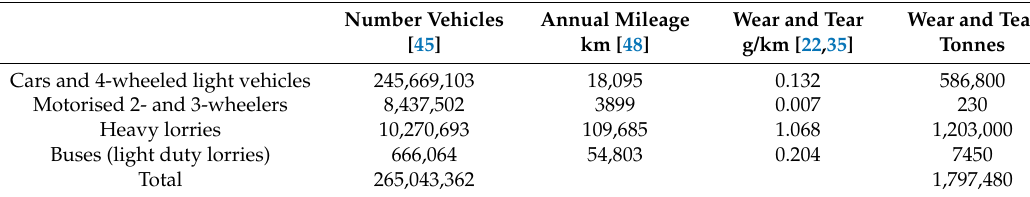
Table 11. Calculation of the amount of tyre wear and tear in the USA [22,35,45,48].